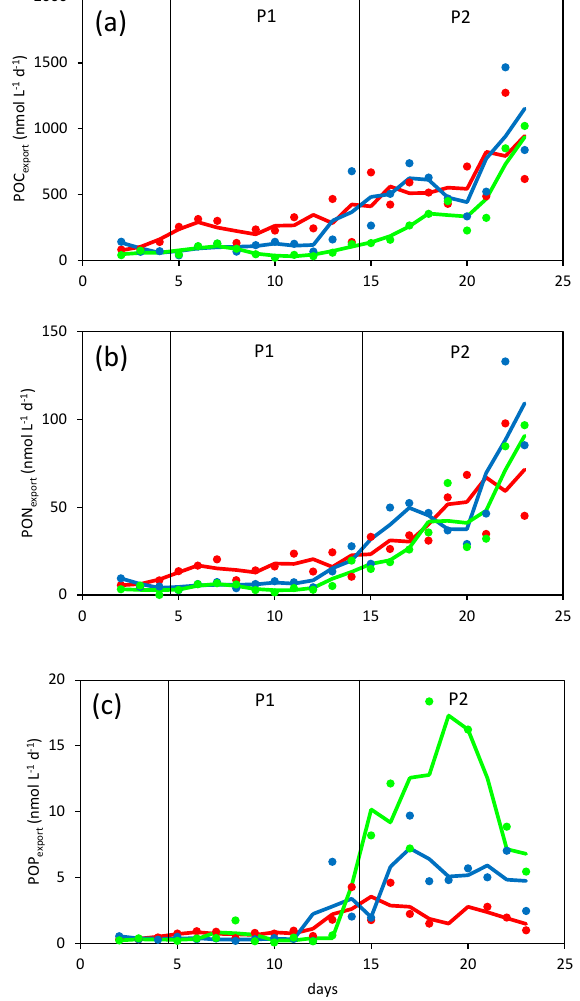
Figure 5. Temporal evolution of (a) particulate organic car- bon exported (POC export ), (b) particulate organic nitrogen ex- ported (PON export ) and (c) particulate organic phosphorus exported (POP export ) fluxes (nmolL − 1 d − 1 ) in the mesocosms expressed in equivalent water volume. The color code is identical to that in Fig. 1. The solid lines are the 3-day running mean value. P1 and P2 denote the two phases of the experiment when the diazotrophic community was dominated by diatom–diazotroph associations and unicellular N 2 -fixing cyanobacteria (group C),